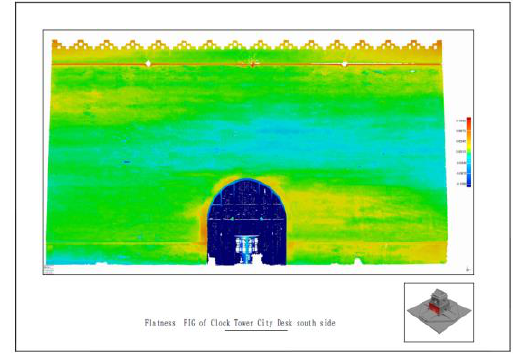
Figure 5. Clock tower wall roughness result map